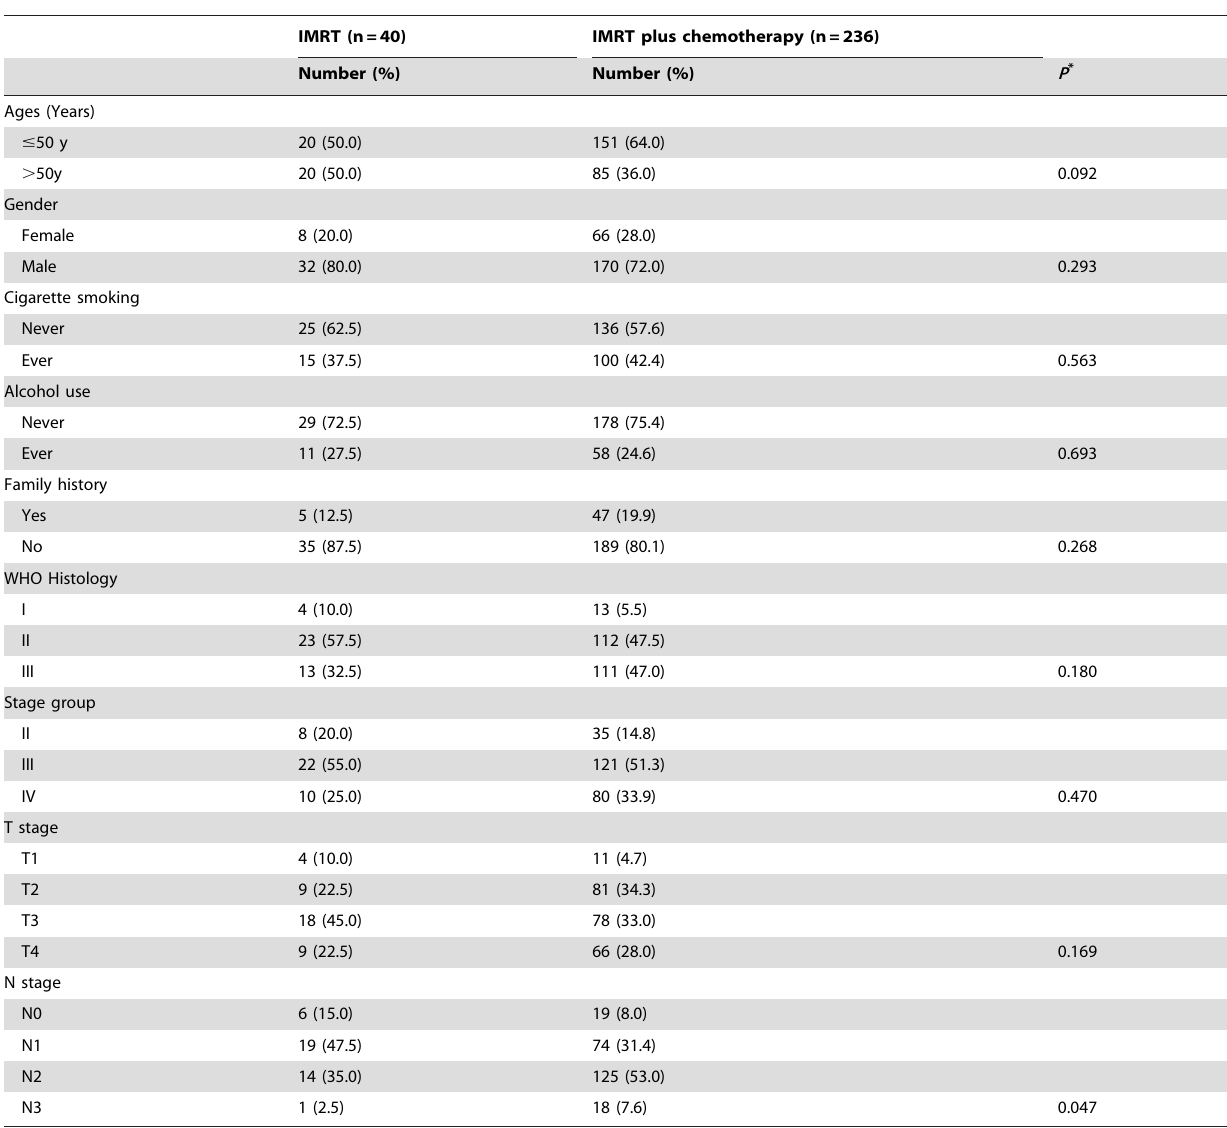
Table 1. Characteristics of patients treated with IMRT alone versus combination of IMRT and